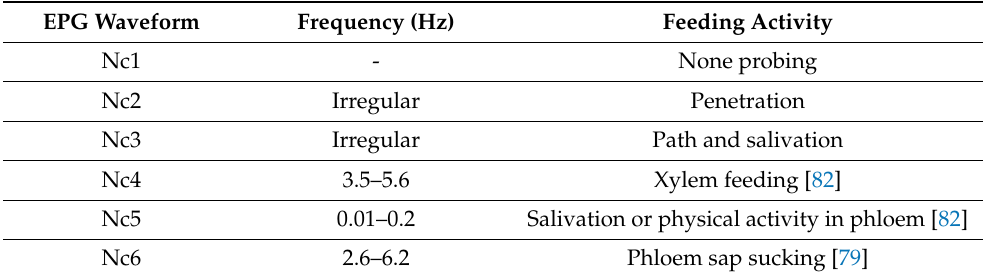
Table 3. EPG information from N. cincticeps nymphs feeding on rice seedlings. EPG